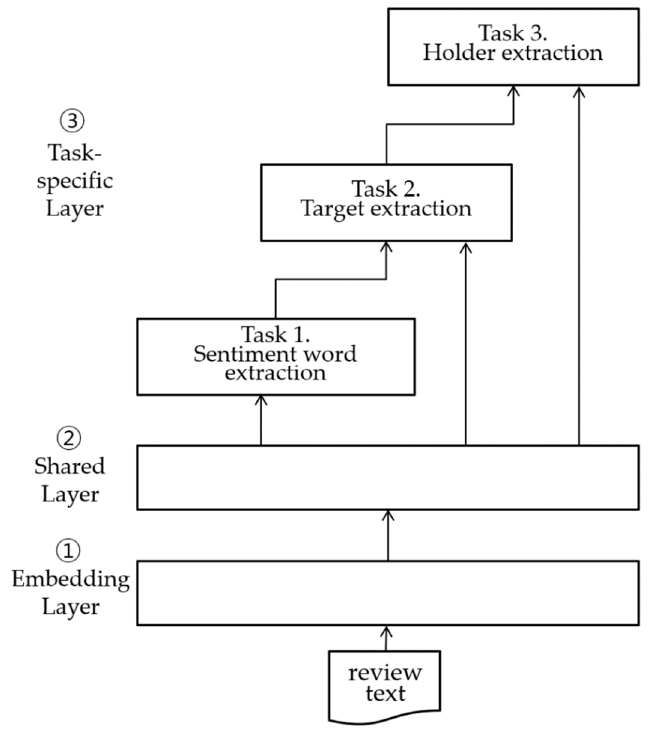
Figure 9. The overall structure of the proposed model.